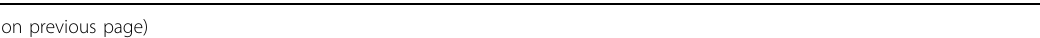
Fig. 4 IKK2 deletion in haematopoietic stem cells results in B-cell lymphocytopenia, T-cell lymphocytosis, granulocytosis, erythrocytopenia and natural killer cell de fi ciency. Moreover, IKK2-deleted mice exhibit reduced numbers of long- and short-term haematopoietic stem cells (HSCs), multipotential progenitors (MPPs), pre-granulocyte – macrophage progenitors, megakaryocyte progenitors (MKp), pre-megakaryocyte – erythroid progenitors (preMegE) and erythroid progenitors (Ep) in the bone marrow. A , B Representative fl ow cytometric plots to examine the haematopoietic compartment of mice of the indicated genotypes. C – K Flow cytometric analysis of total bone marrow harvested from control and IKK1- or IKK2-deleted mice, respectively, at the experimental endpoint. Percentages of A B and T cells, B myeloid populations Mac-1 + /Gr-1 + and Mac-1 + /Gr-1 − , C nucleated erythrocytes and natural killer (Nk) cells, D Lin − Sca-1 + c-Kit + (LSK) cells, E CD48 − CD150 + long-term (LT) HSCs and CD48 − CD150 − short-term (ST) HSCs, F CD48 + CD150 − MPP3 + 4 and CD48 + CD150 − MPP2 cells, G Lin − Sca-1 − c-Kit + (LK) cells, H pre-granulocyte – macrophage progenitors (pre-GM) and granulocyte – macrophage progenitors (GMP) and I megakaryocyte progenitors (MKp) and pre-megakaryocyte – erythroid progenitors (preMegE) and erythroid progenitors (Ep) among CD45.2 + cells in the